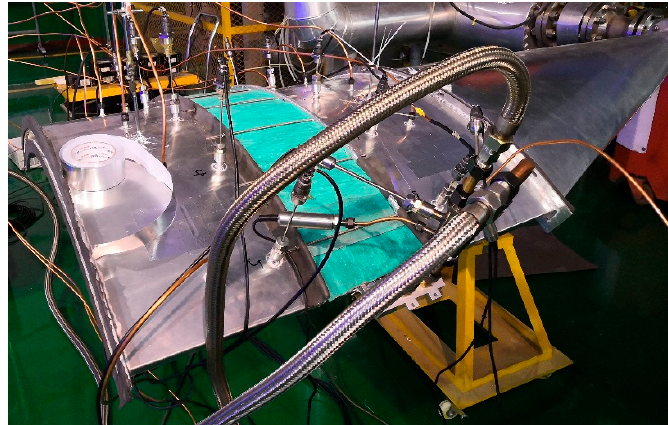
Figure 11. Testing equipment for AR.